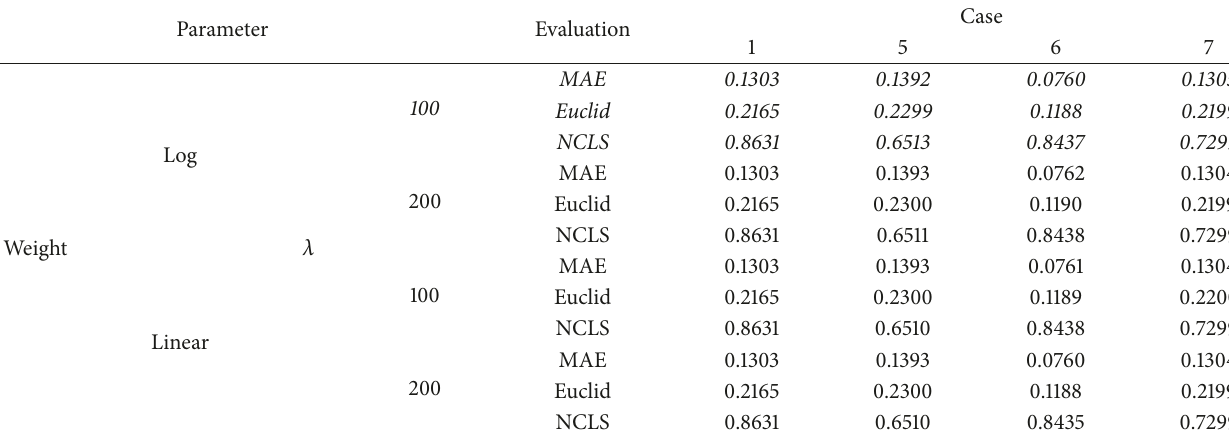
Table 10: Results on parameters of CMA-ES.